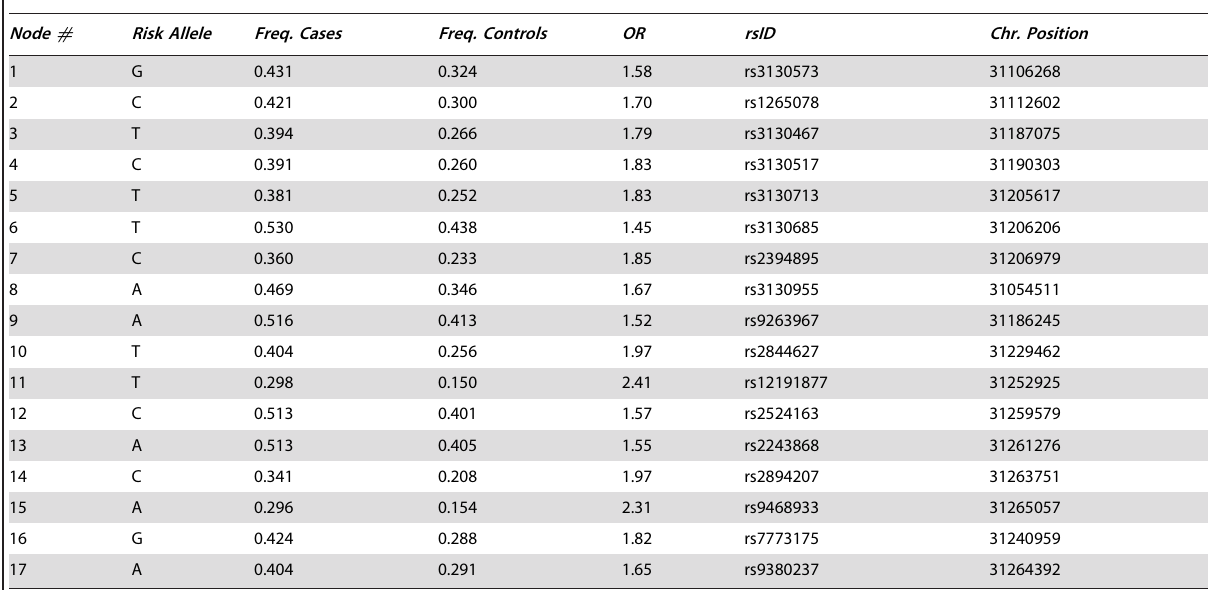
Table 2. Description of SNP alleles corresponding to the nodes in ps_1 .